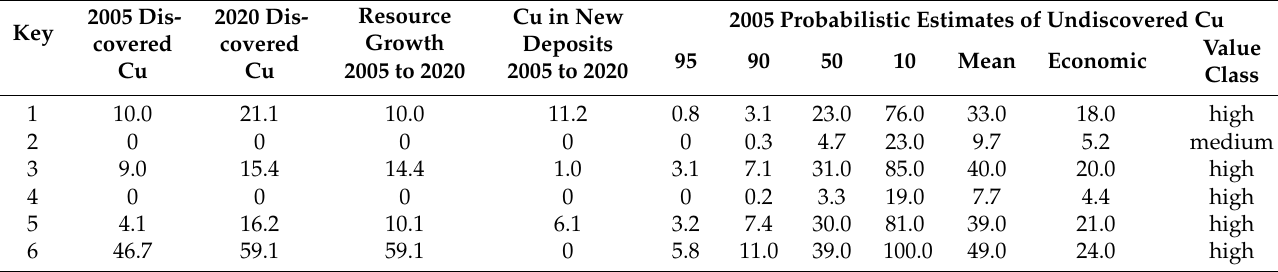
Table 2. Copper resources in million metric